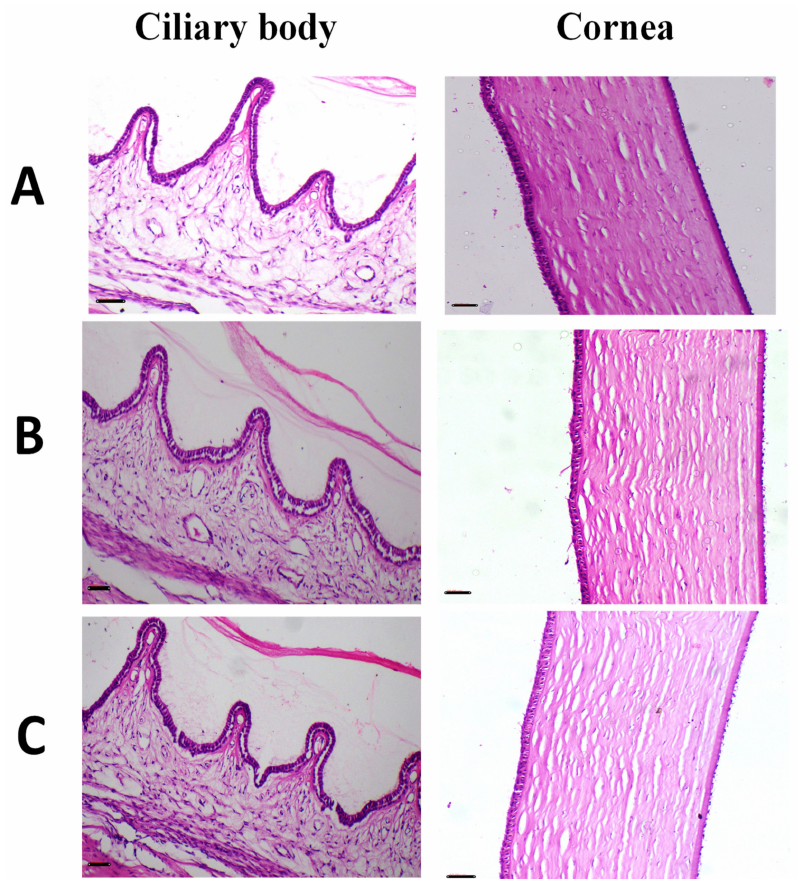
Figure 8. Representative images of H and E stained photomicrographs of eye for one representative rabbit after irritation test for ( A ) Group I; untreated group, act as a control, ( B ) Group II; rhamnolipids nano-micelles solution dispersed in PBS (10 mM, pH 7.4) treated group, and ( C ) Group III; PBS (10 mM, pH 7.4) treated group. All groups treated with samples showed normal histological tissue identical to untreated group after 72 h of treatment with samples. Cornea, fibrous connective tissue appeared normal with no signs of inflammation, erosion, ulcers or necrobiotic changes. Ciliary body appeared also normal with no cutting in the filament of ciliary body with no oedema. Scale bar, 50 µ